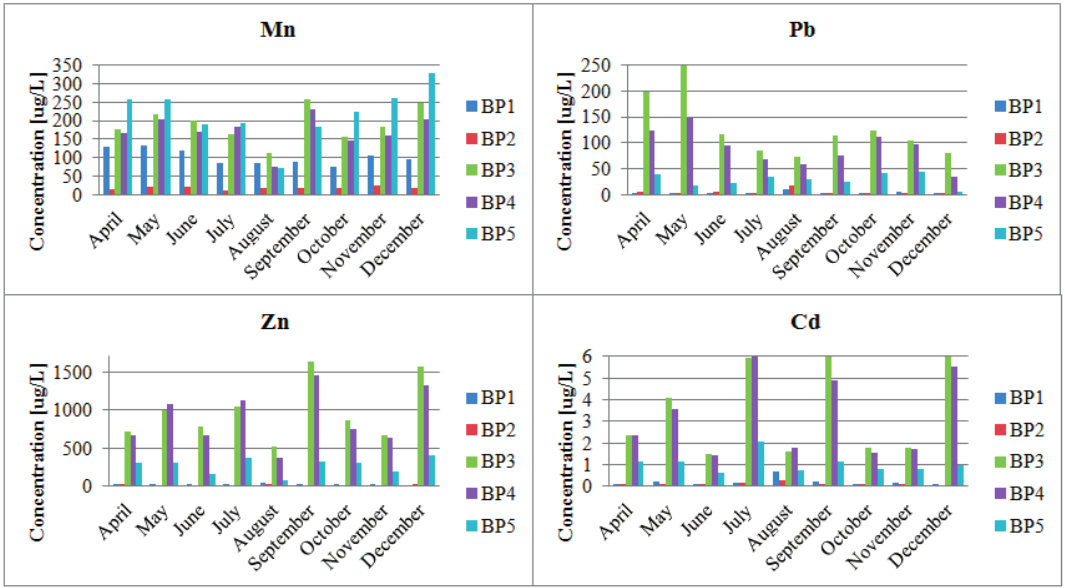
Figure 4. Total contents of manganese, lead, cadmium and zinc in the Bia ł a Przemsza River water; sampling points: BP1—Chrz ą stowice; BP2—Klucze Osada; BP3—D ą